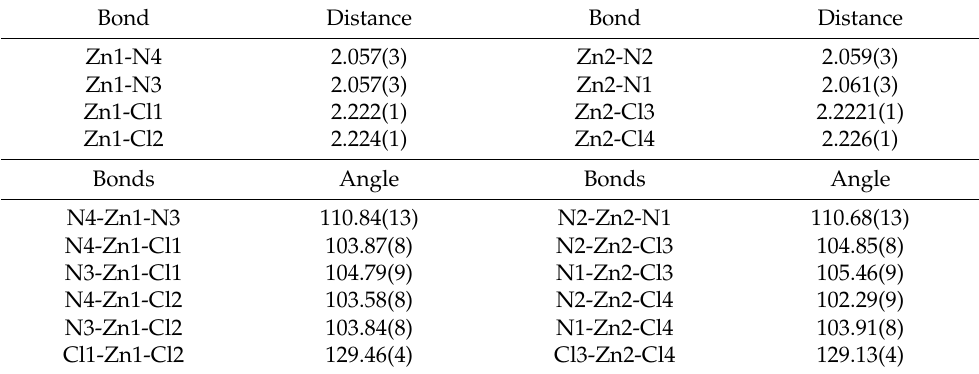
Table 1. The important geometric parameters (Å, ◦ ) in complex 1 .